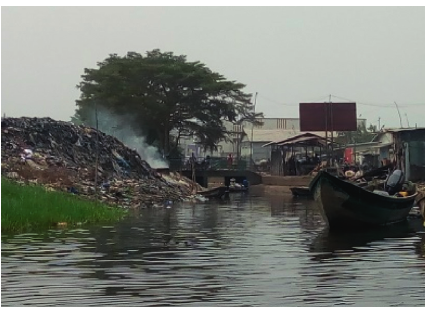
Figure 2: Wild dumpster at Vossa-Cotonou (southwest of Lake